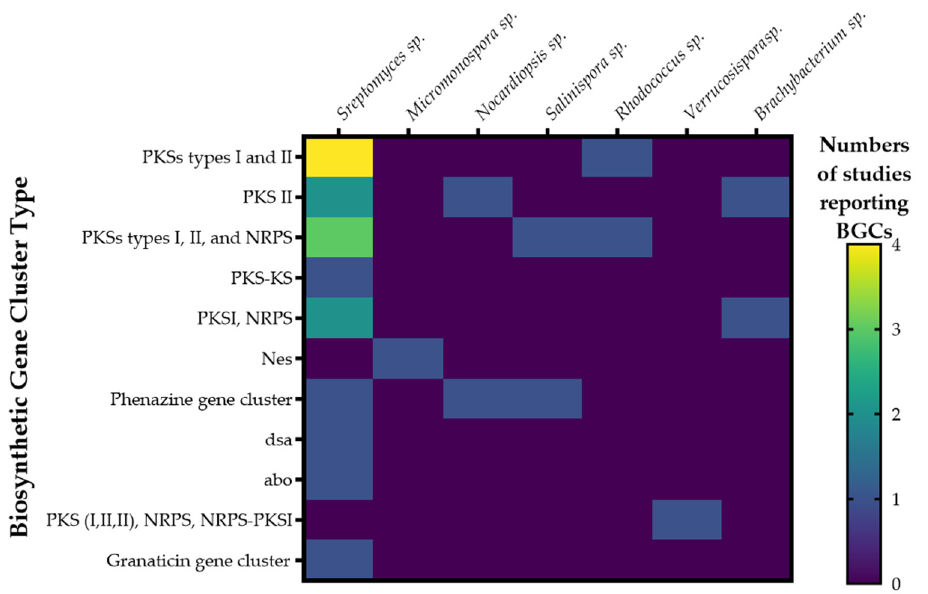
Figure 8. Heatmap of the number and type of biosynthetic gene clusters (BGCs) in the genomes of bioactive strains belongs to different genera collected in this study. Clusters are arranged top to bottom, beginning with the greatest number of BGC types in the top left. Strains are shown left to right by the highest number of BGCs. The most abundant BGCs were Type I and II PKSs followed by NRPS clusters for the Streptomyces genus. The color bar represents the number of studies that reported a type of BGCs, Purple to blue (minor values), blue to green (middle values), and green to yellow (high values).